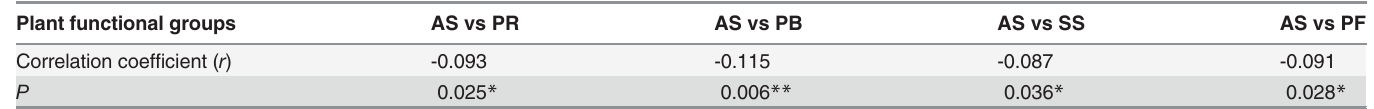
Table 2. Correlation coefficients between annual and perennial functional groups in terms of aboveground biomass. Plant functional